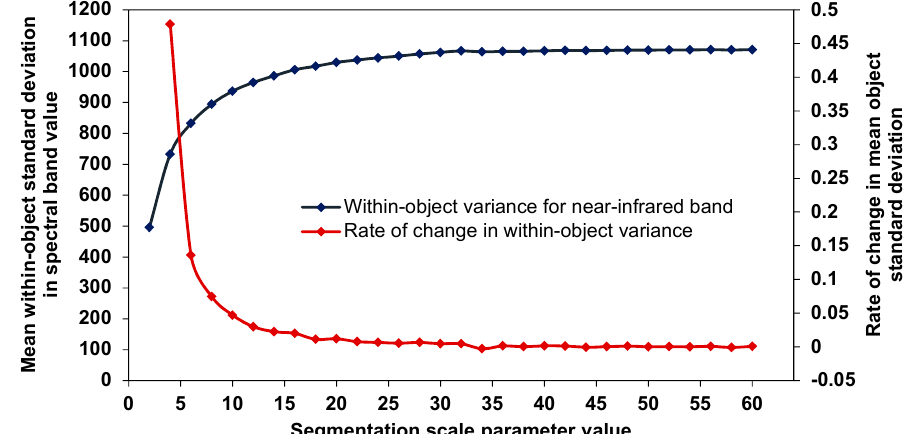
Figure 3. Change in within-object variance and its rate of change with segmentation scale parameter (using near-infrared band as example).